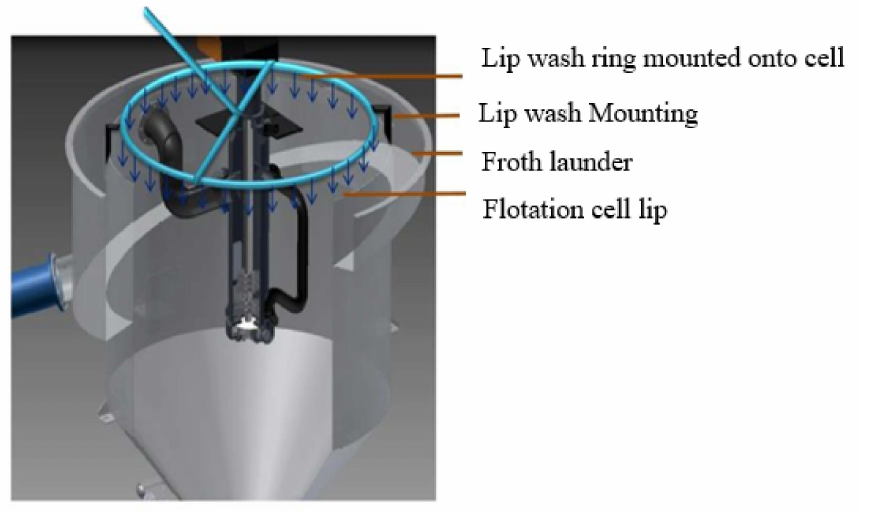
Figure 8. Lip washing on a Dual Cell Flotation Cell